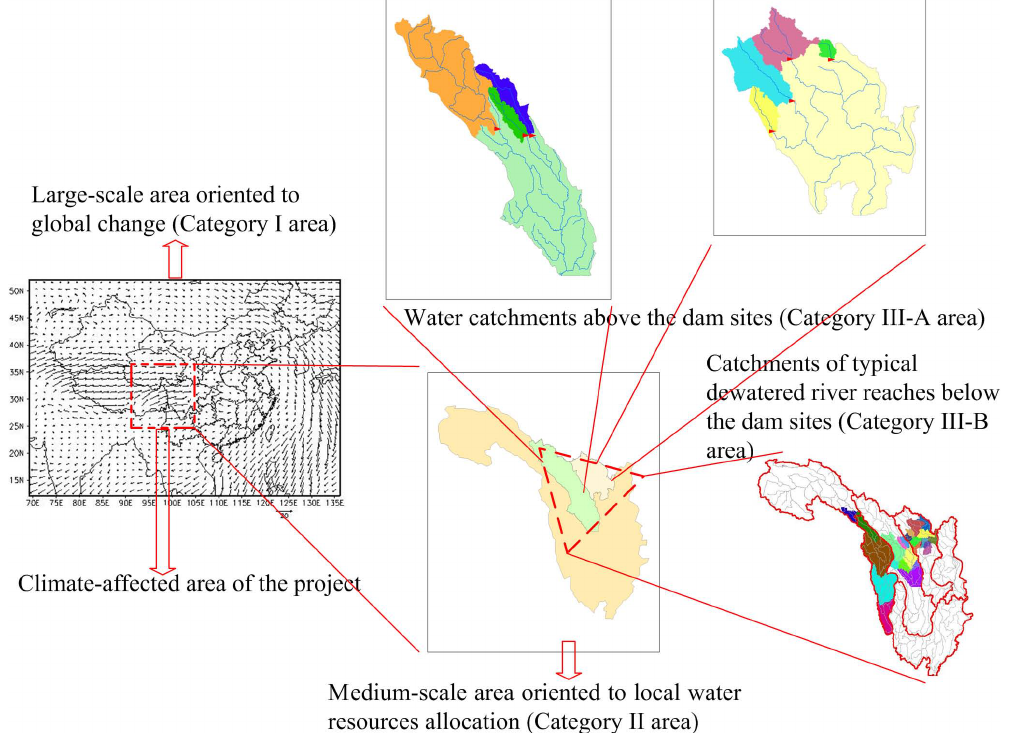
Fig. 2. The spatial scales for